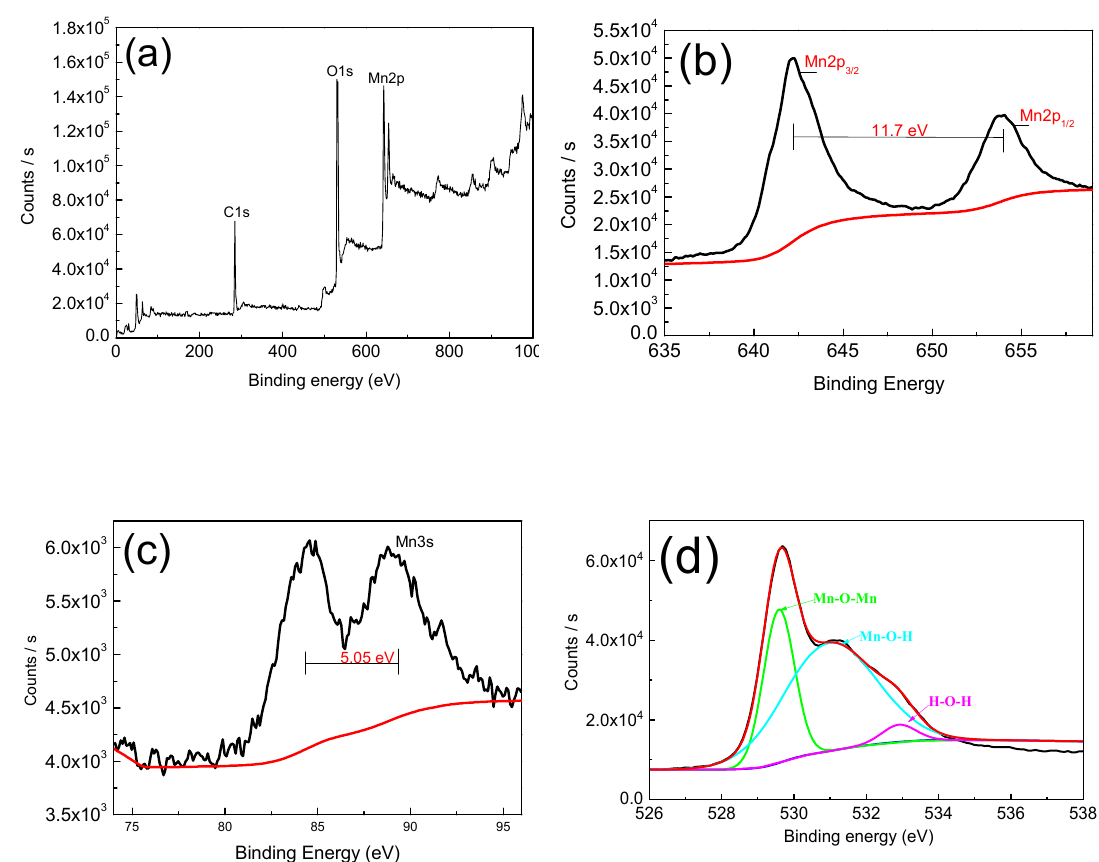
Figure 4. ( a ) X-ray photoelectron spectroscopy (XPS) spectra of MnO 2 film; ( b , c ) Mn2p and Mn3s core level spectra; ( d ) O1s core level spectra.